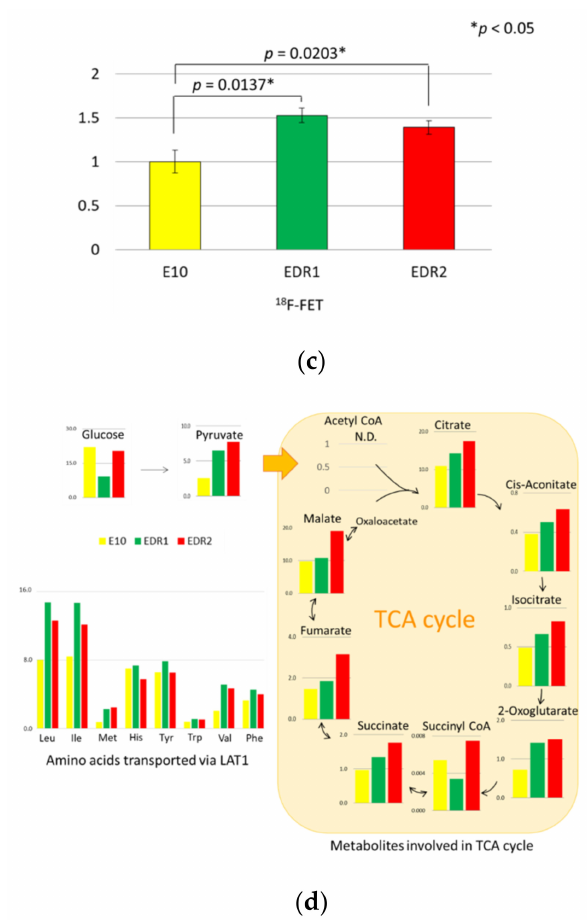
Figure 4. LAT1 ( a ) and LAT3 ( b ) expression in three breast cancer cell lines examined by Western blotting with β -actin as a protein loading control. Cellular uptake of 18 F-FET radiotracers in three breast carcinoma cell lines ( c ). Metabolome analysis of three breast carcinoma cell lines. These amino acids levels imported by LAT1 corresponded to intermediates of the TCA cycle ( d ). The data was analyzed by the Student’s t -test. * p < 0.05.